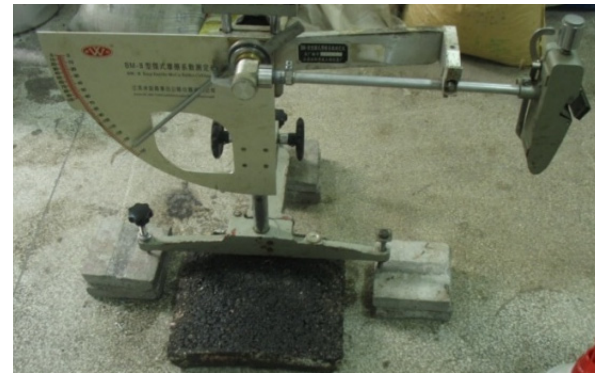
Figure 8. British pendulum number (BPN) test for the arc-shaped specimens.